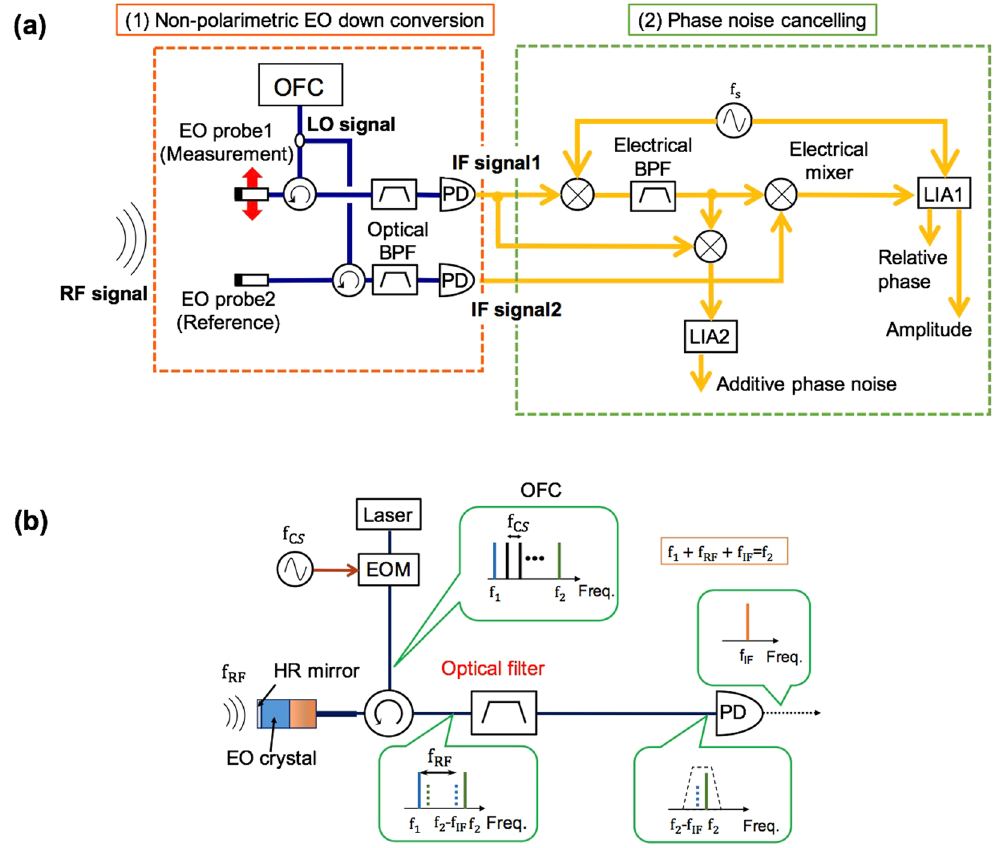
Figure 2. Basic configuration of the measurement setup. ( a ) System block diagram and ( b ) principle of the non-polarimetric EO frequency down conversion.